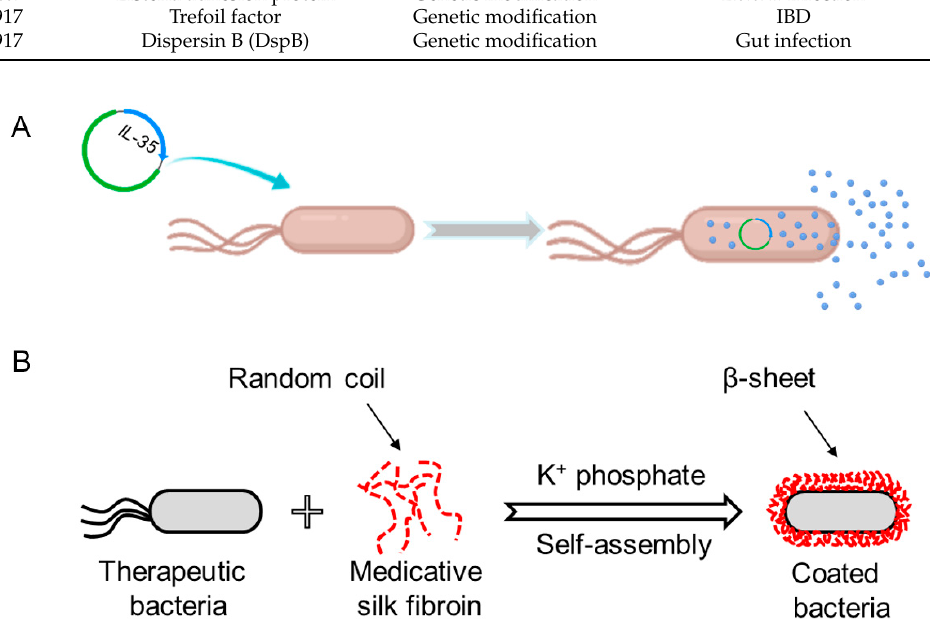
Figure 2. Engineered bacteria for the oral delivery of therapeutic proteins. ( A ) Oral delivery of heterogeneous interleukin (IL)-35 expressed by genetically modified bacteria. Adapted from [47], published by Springer, 2019. ( B ) Oral co-delivery of therapeutic silk fibroin and probiotics through self-assembly on the surface of bacteria for synergistically enhanced biotherapy. Adapted with permission from [50]; published by Wiley-VCH, 2021.